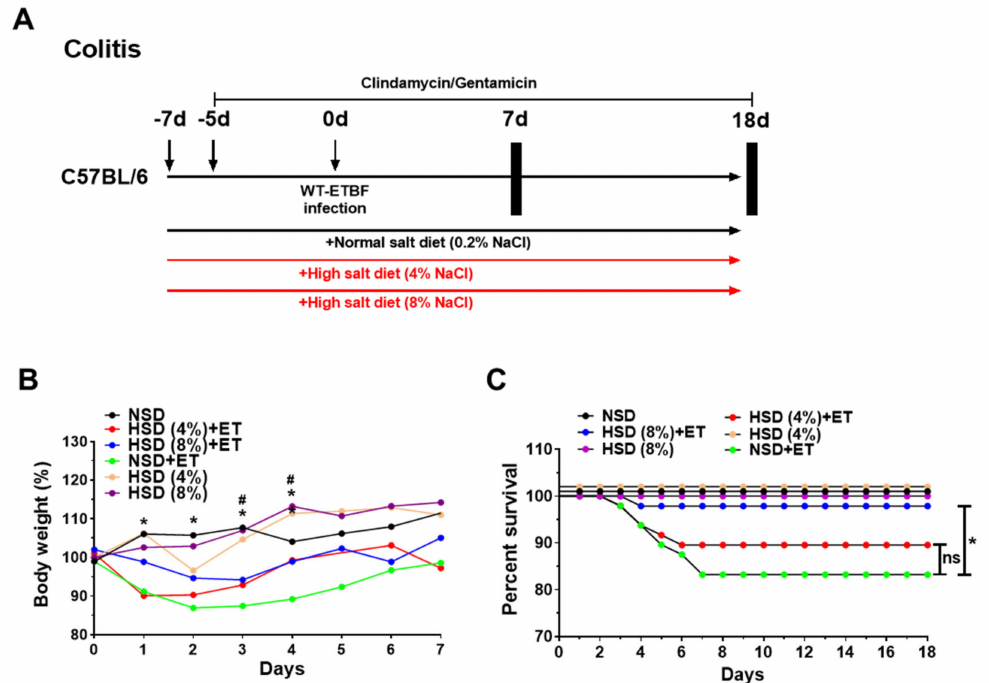
Figure 1. Experimental scheme and e ff ects of high salt diet (HSD) on body weight and survival curve in enterotoxigenic Bacteroides fragilis (ETBF)-infected mice. Eight-week-old C57BL / 6 female mice were inoculated with WT-ETBF (~1 × 10 9 CFU). HSD (4% and 8%) treated groups were given chow containing either 4% NaCl or 8% NaCl, respectively. C57BL / 6 mice were sacrificed at day 7 (acute infection) or day 18 (chronic infection) post-infection. The total experimental period was 25 days. ( A ) Experimental design of the ETBF-induced colitis model. ( B ) Body weight change (days 1–7). The daily body weights of individual mice were normalized to their starting body weights. ( C ) Survival curve of C57BL / 6 mice. Kaplan–Meier curves depicting survival after WT-ETBF infection. Results were pooled from three independent experiments ( n = 15–20 mice per group). * p < 0.05, Mantel–Cox log-rank test. NSD, normal salt diet; HSD, high salt diet; ET, ETBF. HSD (4%) + ET vs. NSD + ET, * p < 0.05; HSD (8%) + ET vs. NSD + ET, # p < 0.05. Significance between treated groups was determined using Mann–Whitney U tests. * p < 0.05; ns, no statistical